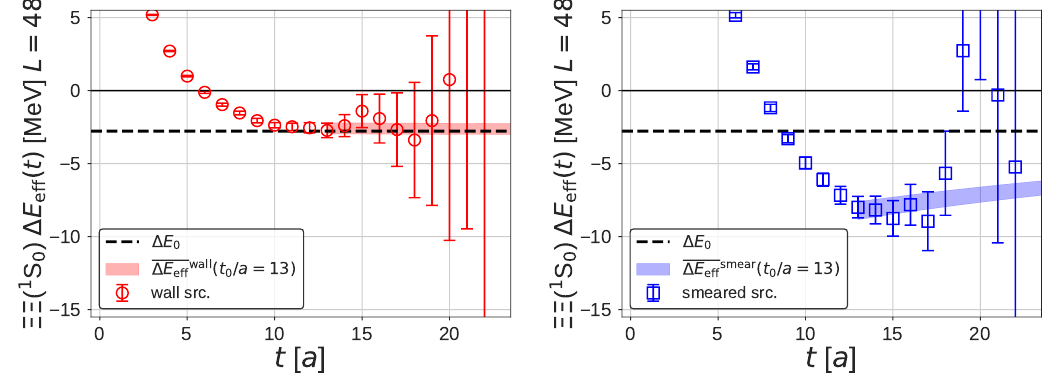
Figure 10 . The reconstructed e(cid:11)ective energy shifts (cid:1) E e(cid:11) ( t; t 0 = 13 a ) with statistical errors are plotted as a function of t (colored bands), while the direct measurement of the e(cid:11)ective energy shifts from R -correlators are plotted by red circles or blue squares. The black dashed lines correspond to the energy shift (cid:1) E 0 ( t 0 = 13 a ) for the ground state of the HAL QCD Hamiltonian H LO in the (cid:12)nite volume. The results on L = 48 for the wall source (left) and the smeared source